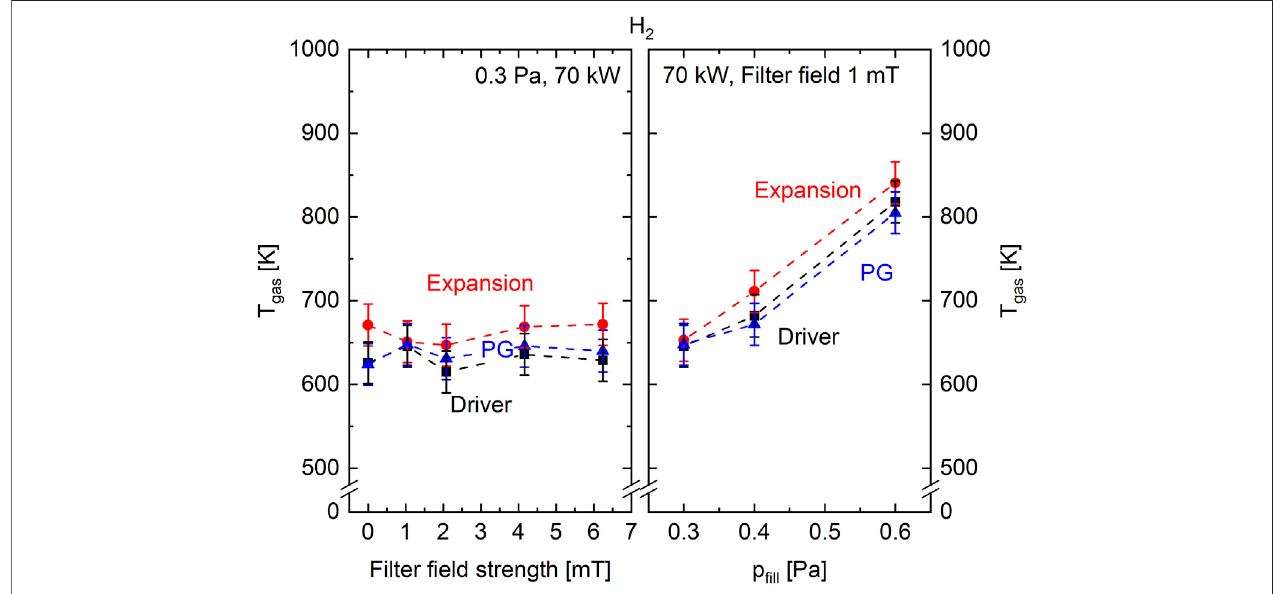
FIGURE4| GastemperatureevaluatedfromOESforvarying fi lter fi eldstrengthsand fi llingpressuresusingLOSrepresentingthedifferentplasmaregions.The fi lter fi eld strength values are given for a position of 2 cm away from the PG surface and both vertically and horizontally centered.